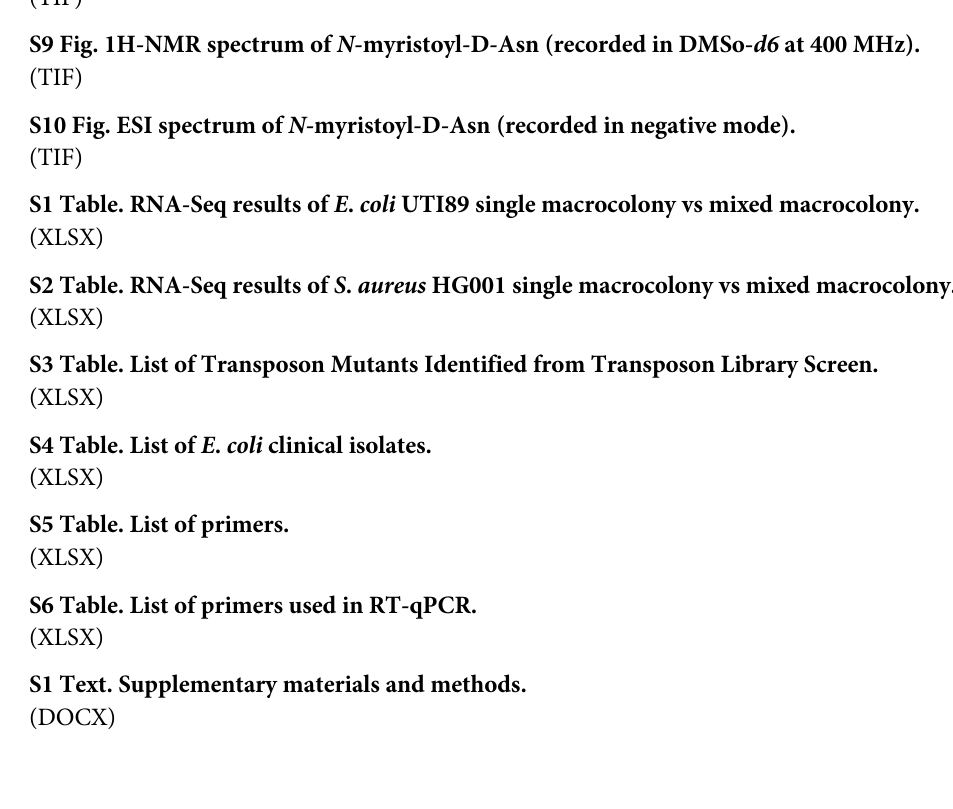
S8 Fig. NMDA synthesis scheme.